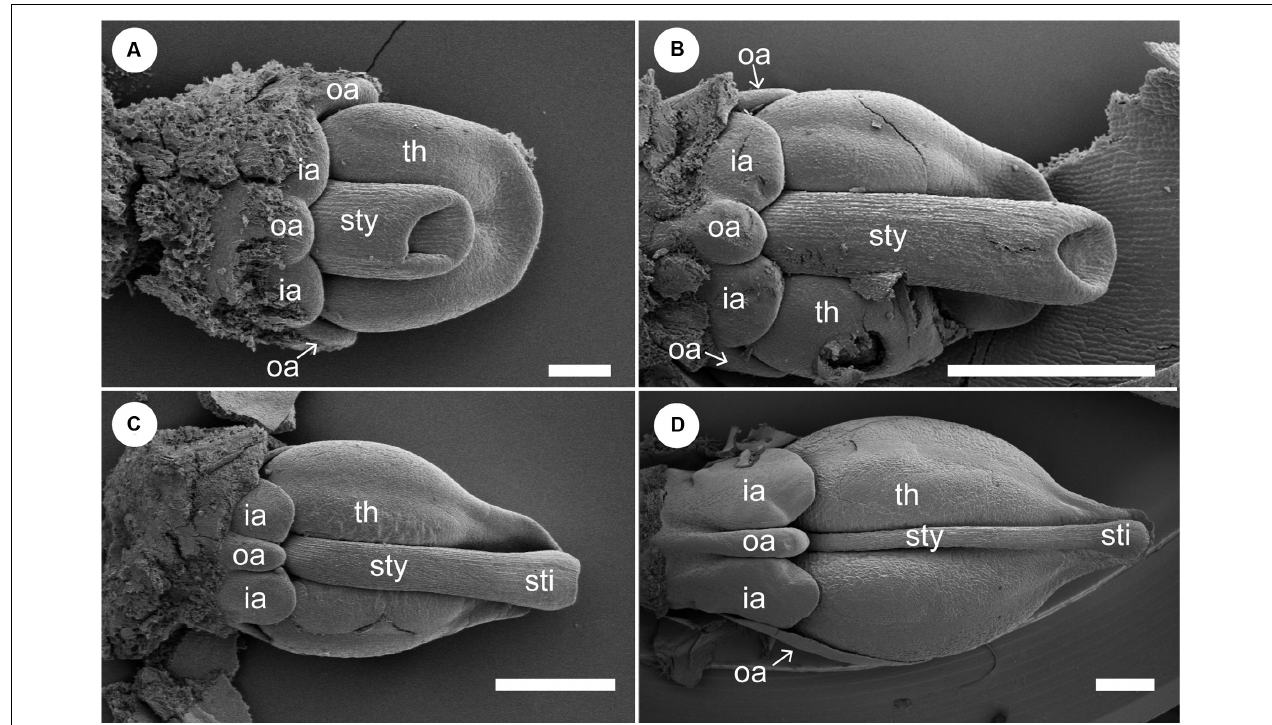
FIGURE 9 | Floral development of Gagnepainia harmandii (continued). Petals and sepals are removed. (A , B) Flowers at a late stage. The style (sty) elongates and is enclosed within the thecae (th). The abaxial outer androecial primordium (oa) and two inner androecial primordia (ia) develop and form a labellum primordium, while the other outer androecial primordia develop along the lateral sides of the stamen. (C , D) The abaxial outer androecial primordium elongates and becomes a long carina of the labellum. The inner androecial primordia also develop into lateral wings of the labellum. The lateral outer androecial primordia develop into petaloid staminodes along the lateral sides of the stamen. The style elongates and is tightly enclosed within the thecae. ia, inner androecial primordium; oa, outer androecial primordium; th, thecae; sti, stigma; sty, style. Scale bars = 500 µ m.